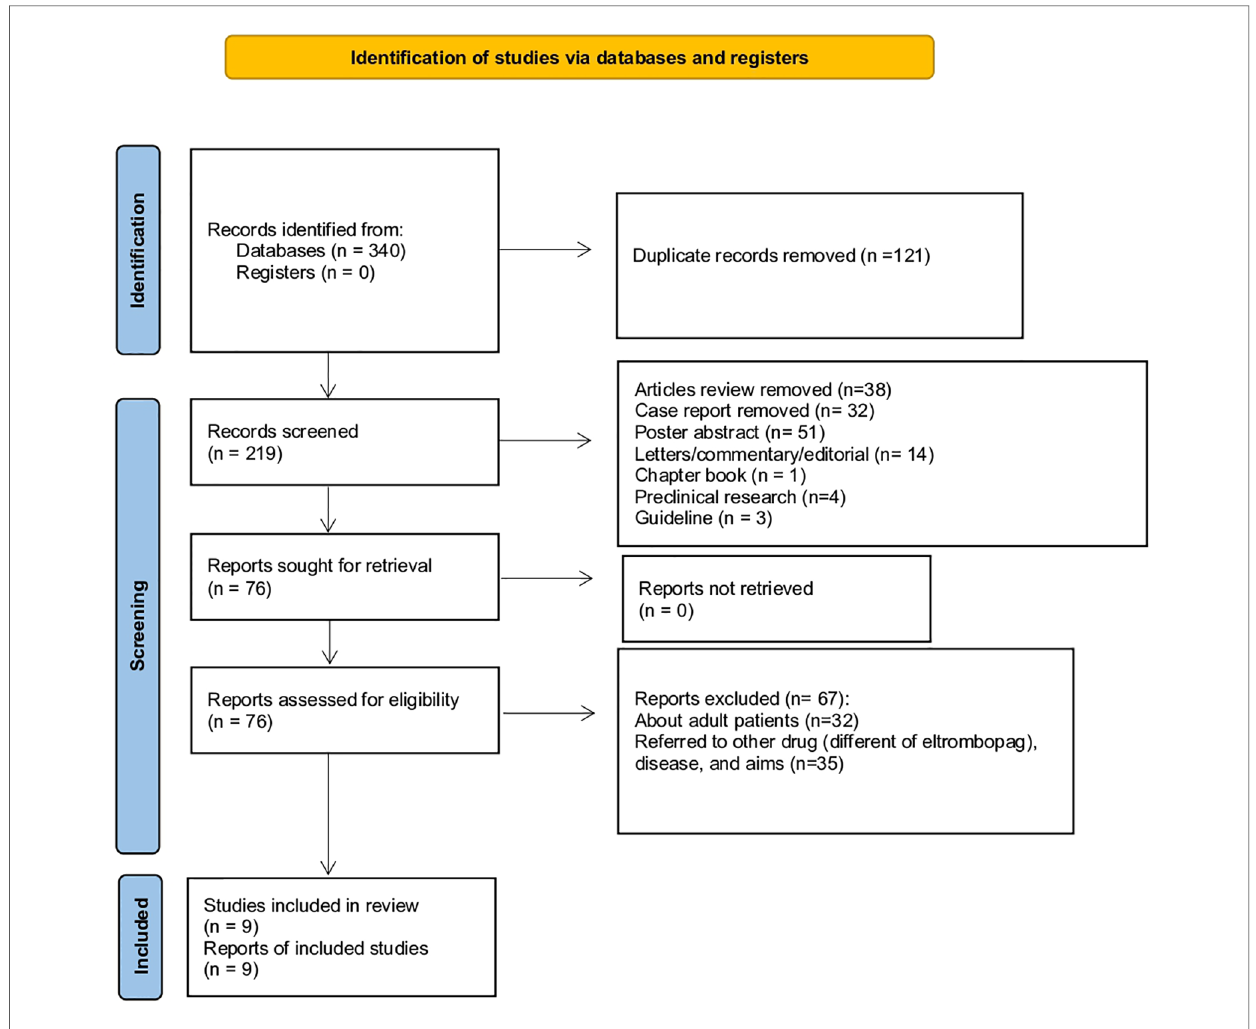
FIGURE 1 PRISMA fl owchart of the identi fi cation and inclusion of systematic